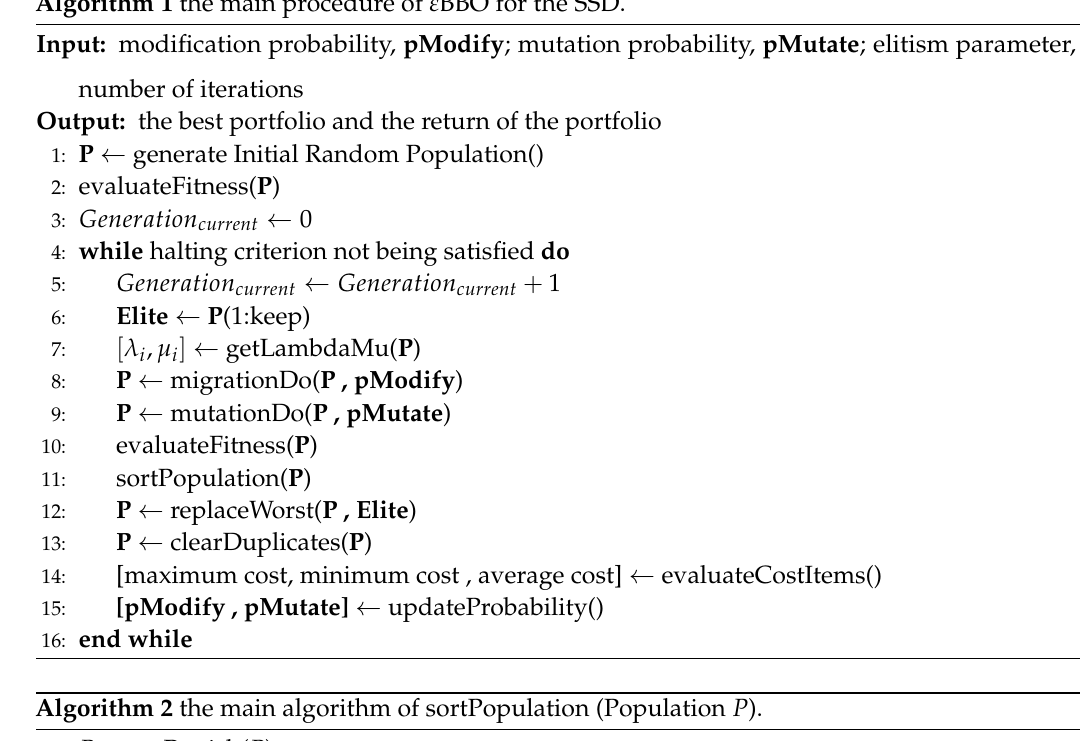
Algorithm 1 the main procedure of ε BBO for the SSD.